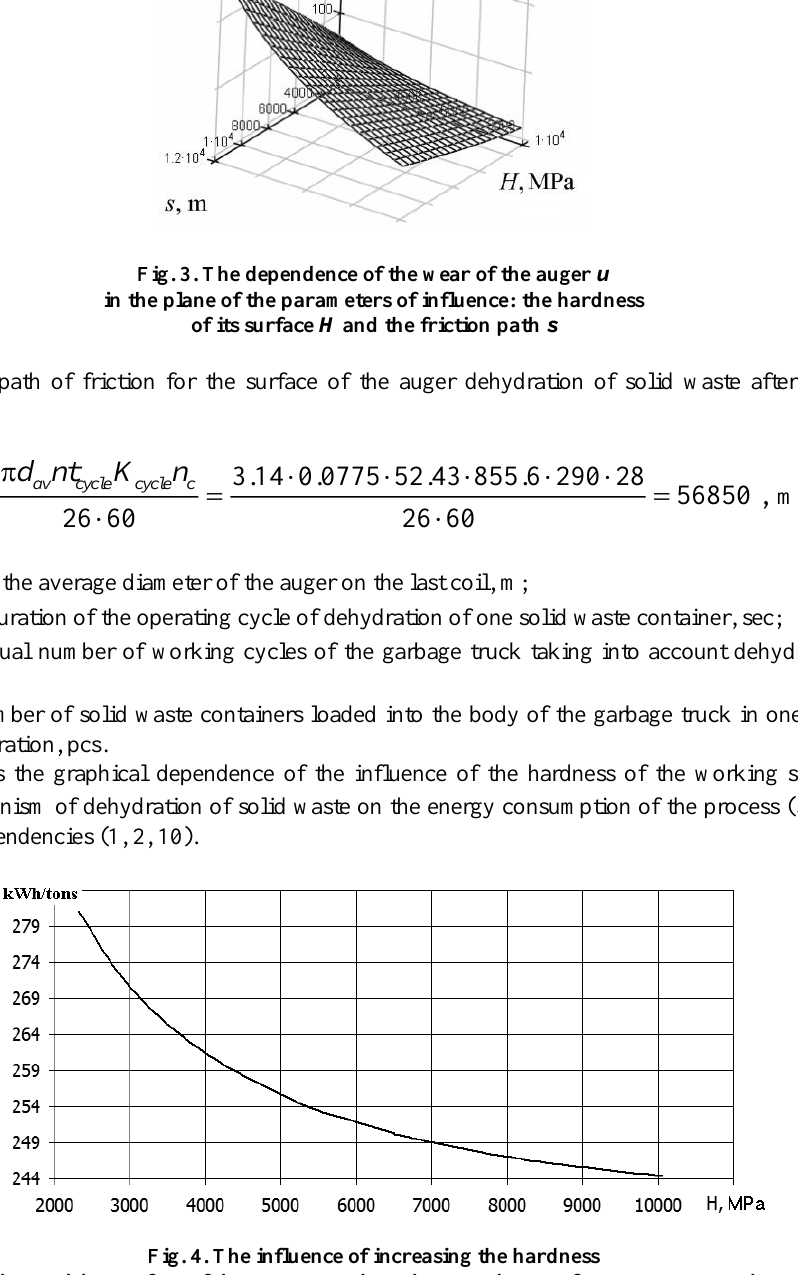
Fig. 4. The influence of increasing the